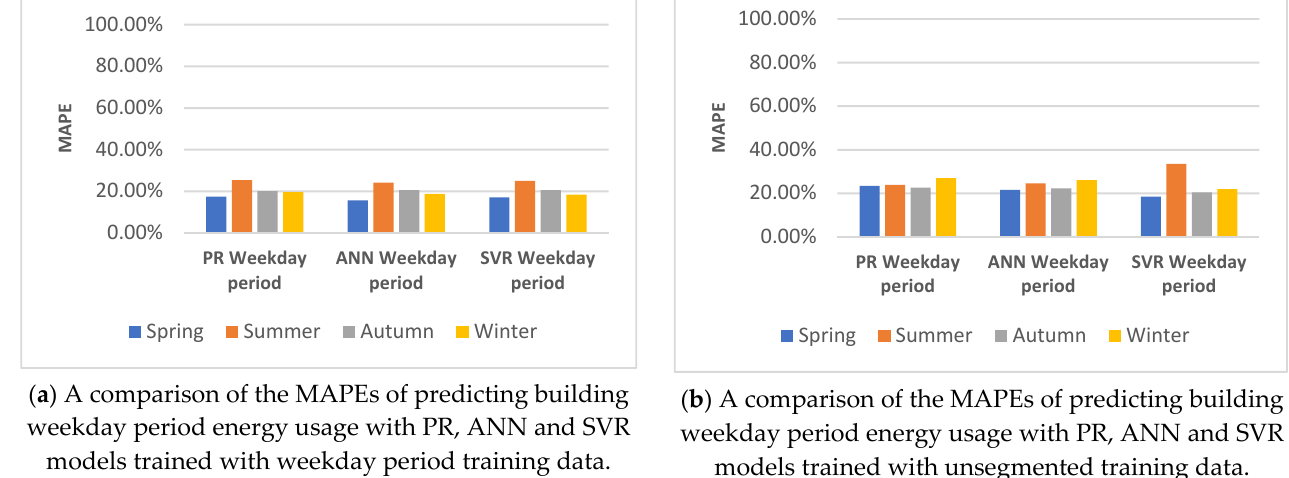
( f ) A comparison of the MAPEs of predicting building energy usage with PR, ANN and SVR models trained with unsegmented training data. Figure 20. A comparison of active/dormancy segmented machine learning techniques monthly MAPE.